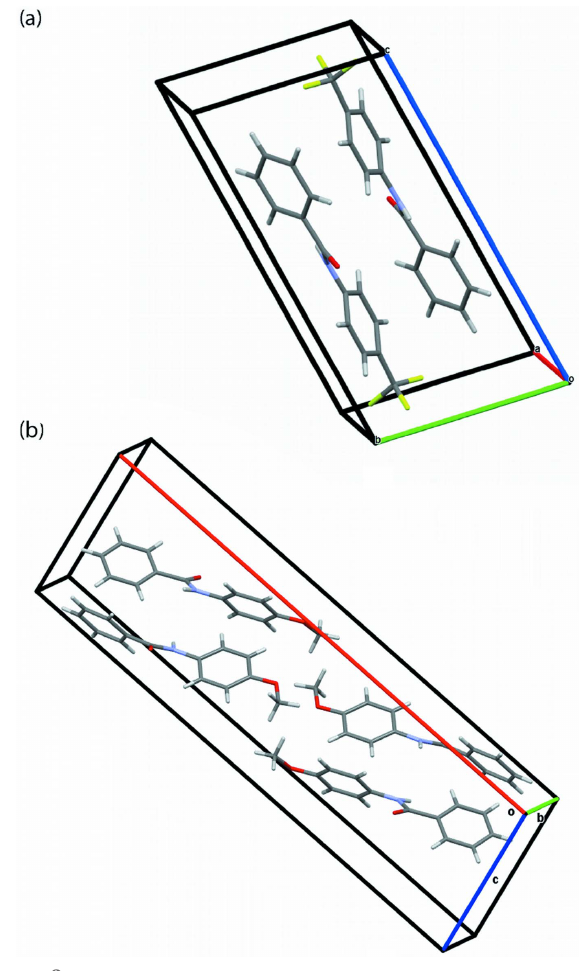
Figure 2 Unit-cell packing of ( a ) TFMP and ( b ) MOP .